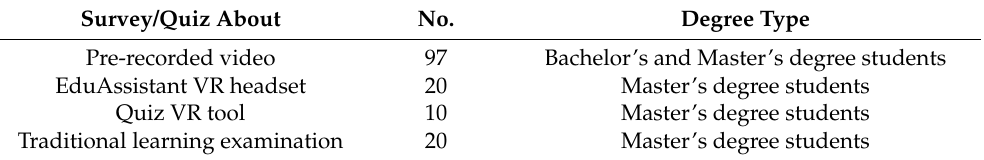
Table 4. Total number of participants for each